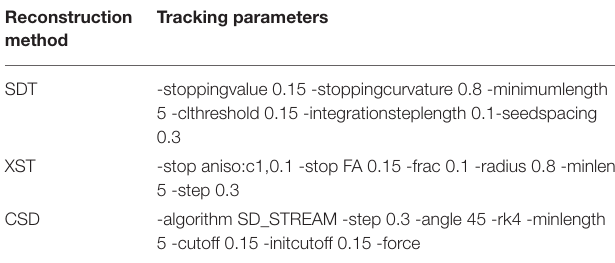
TABLE 2 | Tracking parameters used for each reconstruction method.